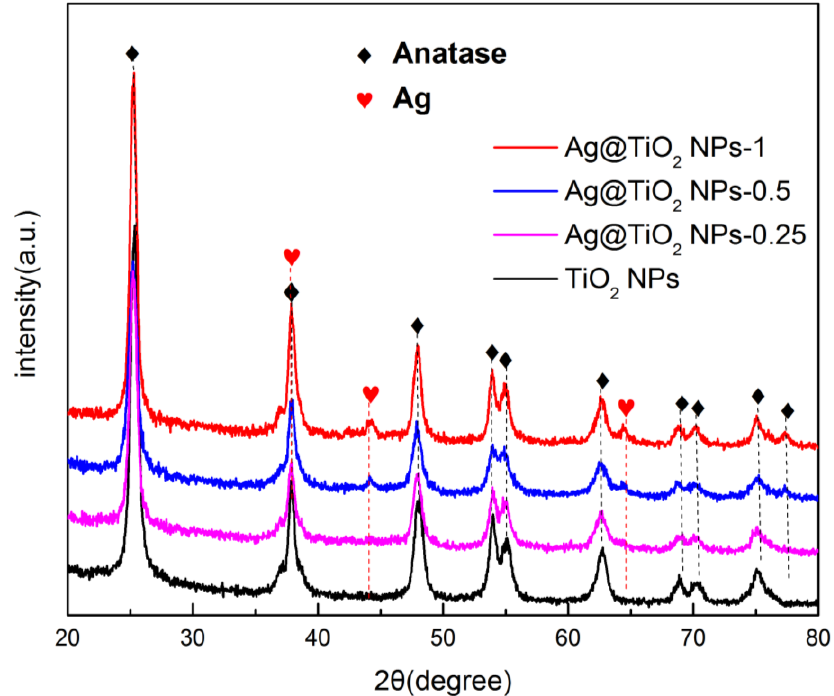
Figure 3. X-ray diffraction (XRD) patterns of pure TiO 2 NPs, Ag@TiO 2 NPs with different molar ratios of 0.25%, 0.5% and 1%.